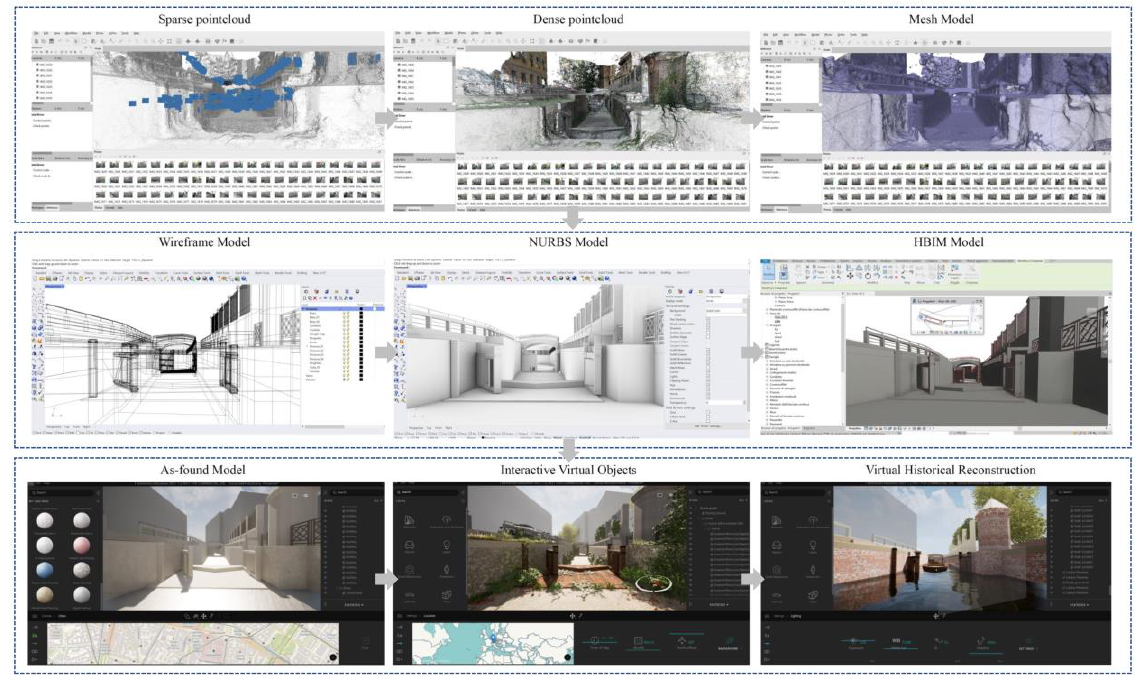
Figure 10 . The research method applied to the Conca dell’Incoronata: from scan-to-BIM objects to IVOs and the virtual historical